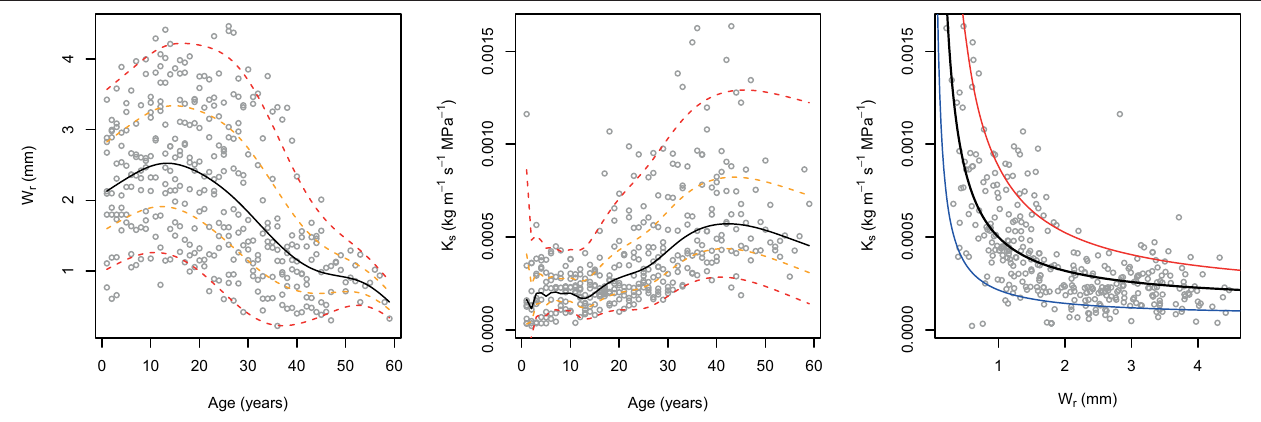
FIGURE 3 | Tree-ring width (W r ) and specific hydraulic conductivity (K s ) centile curve (left and central panels, respectively) using the LMS method as a function of cambial age. Each panel shows the 5 th , 25 th , 50 th , 75 th , and 95 th percentile from the bottom to the top, respectively. Scatter plot between K s and W r with non-linear [K s ∼ I(1/W r * a) + b] quantile regression line (right panel) . The black line is median (a, β = 3.505e-04, p < 0.001; b, β = 1.377e-04, p < 0.001), the red line is the 90th quantile (a, β = 0.00069, p < 0.001; b, β = 0.00018, p < 0.001), and the blue line is the 10th quantile (a, β = 0.00015, p < 0.001; b, β = 0.00008, p < 0.001).